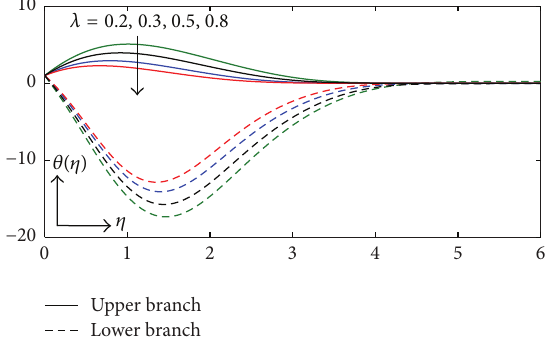
Figure 10: Temperature profiles for various values of 𝜆 with 𝑠 = −3 , 𝛾 = 1 , 𝑀 = 0.2 , and Pr = 3 .